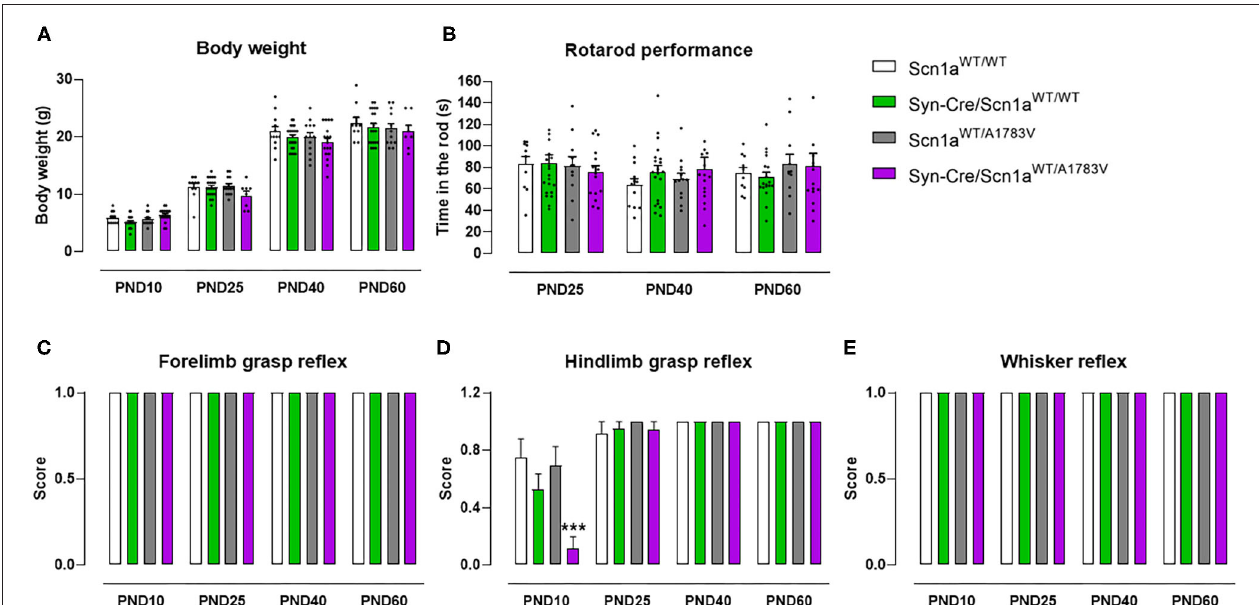
FIGURE 1 | Evolution of body weight, rotarod performance, forelimb and hindlimb grasp reflexes, and whisker reflexes in Syn-Cre/Scn1a WT / A1783V mice and their three control groups (Scn1a WT / WT , Syn-Cre/Scn1a WT / WT , and Scn1a WT / A1783V mice) measured at different postnatal days in the range PND10-PND60. Values are means ± SEM of 12–21 animals per group. Data were assessed by using two-way ANOVA for repeated measures followed by the Bonferroni test (*** p < 0.005 vs. the other three groups).